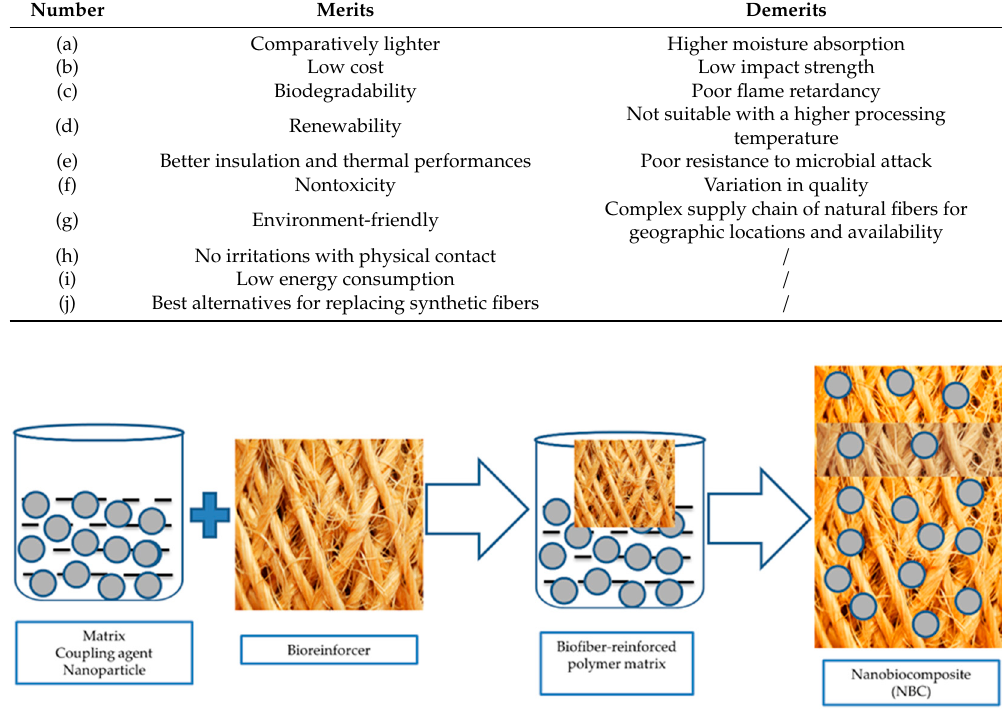
Figure 2. Formation mechanism of nanobiocomposites (NBCs) .